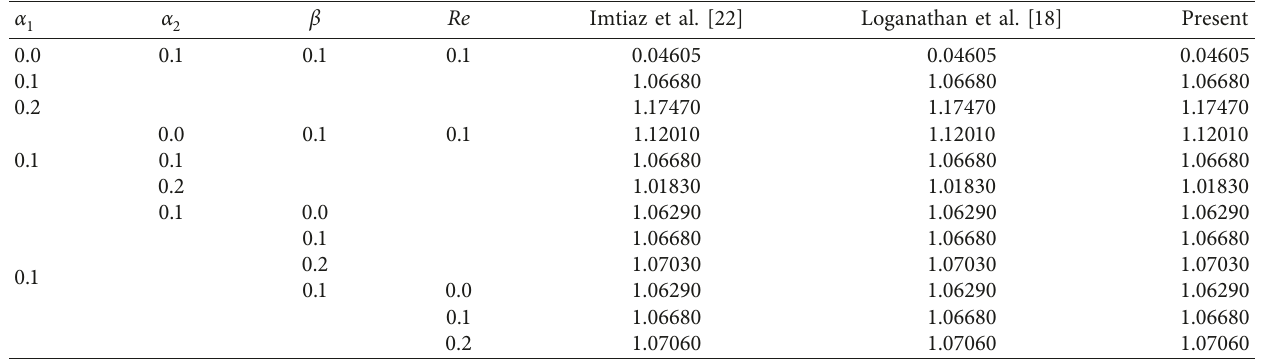
Re − 0 . 5 for the limiting conditions. P f